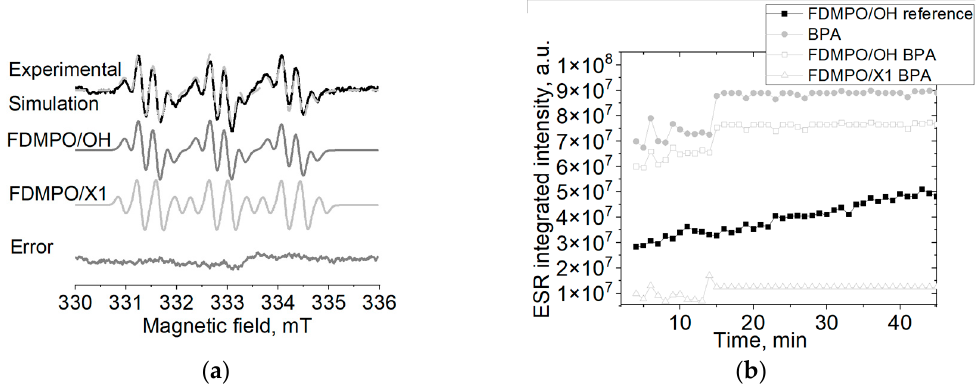
Figure 1. ( a ) ESR spectra of FDMPO radicals adducts formed in the presence of BPA under Fenton reaction; ( b ) Kinetics of the integrated intensity of ESR spectra from FDMPO radical adducts formed in the presence of BPA under Fenton reaction.